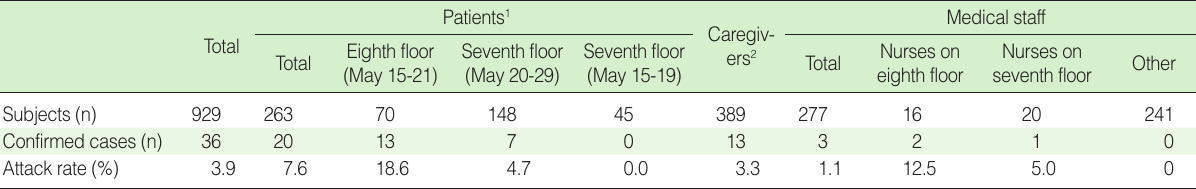
Figure 3. Boxplots for days of MERS outbreak by generation in Pyeongtaek St. Mary’s Hospital, Korea. (A) Incubation period (p = 0.227), (B) symptom onset to confirmation (p = 0.003), (C) symptom onset to discharge (p = 0.002), and (D) symptom onset to death (p = 0.533). The p­values were obtained by Mann­Whitney U Table 1. Attack rate of MERS at Pyeongtaek St. Mary’s Hospital, Korea